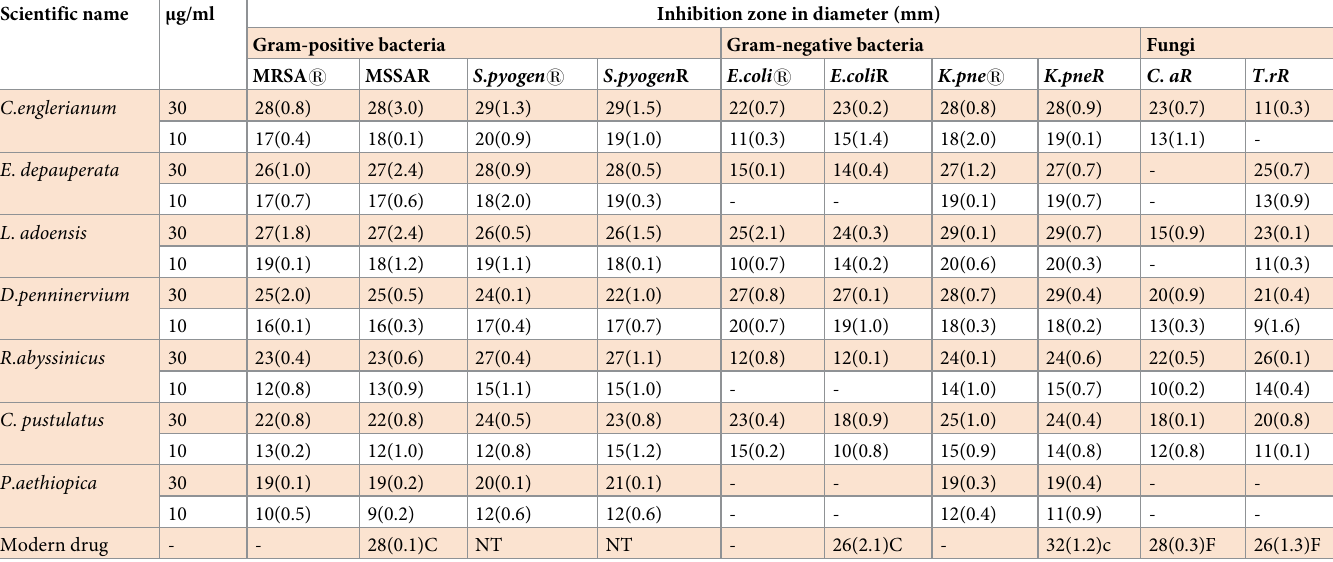
Table 1. Methanolic extracts inhibition zone in diameter on human pathogens on agar disc diffusion method performed at AAU, 2018. Scientific